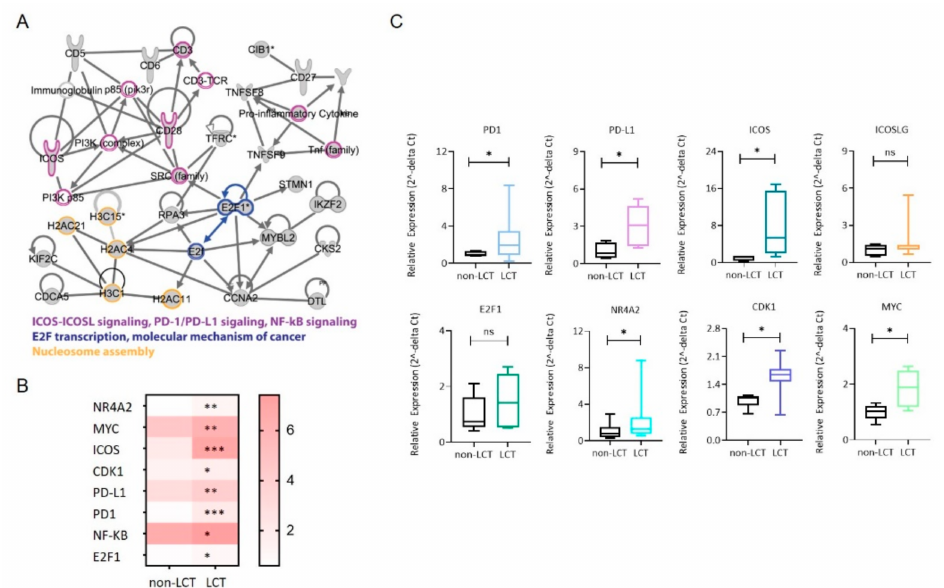
Figure 4. Identification of signaling network of upregulated mRNAs that positively correlate with miR-21 and miR-146a. ( A ) Functional interaction network of upregulated genes in LCT-MF. The 130 genes that are upregulated in LCT-MF and positively associated with miR-146a and miR-21 were subjected to network analysis using Ingenuity Pathway Analysis (IPA). The nodes are colored based on their associated canonical pathways. ( B ) Heatmap visualization of differential expression key genes in MF-LCT vs. non-LCT. * p < 0.05, ** p < 0.01, *** p < 0.001. ( C ) qRT-PCR validation of key genes of the targeted signaling in LCT-MF and non-LCT lesional skin samples. Data are shown as means ± SD. Variables were analyzed using Student’s t test (* p < 0.05); ns, no significant